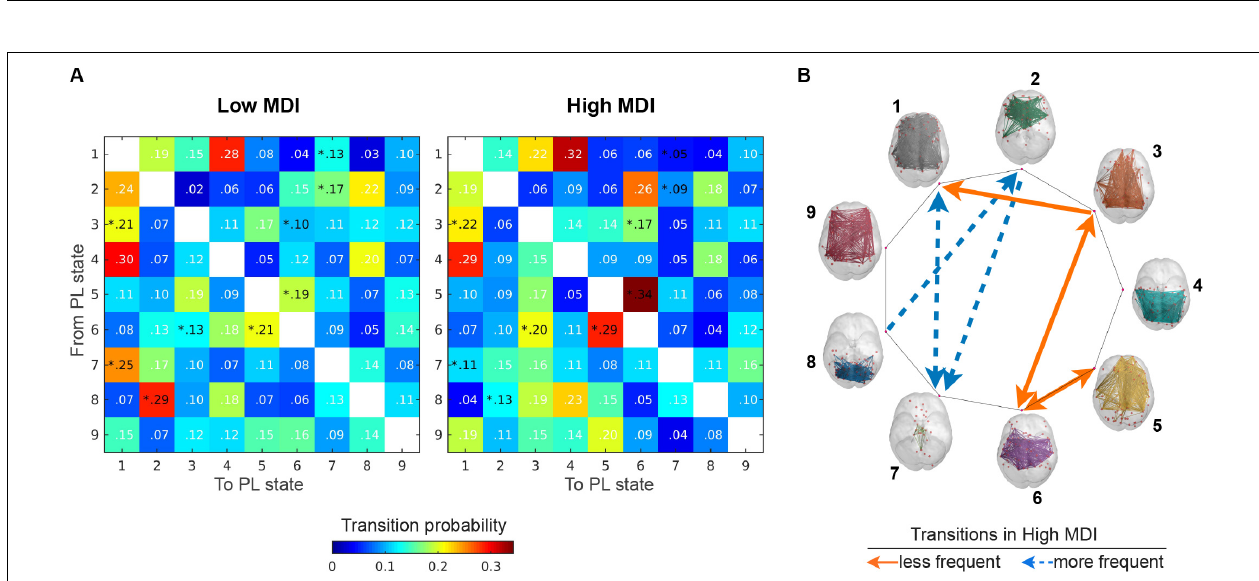
FIGURE 6 | Precuneus FC for the repertoire of nine PL states. (Top) Subnetworks determined by the largest (blue) and smallest (orange) communities in each cluster centroids Vc. Note that Vc captures the main orientation of BOLD phases over all regions and that the sign (positive or negative) of the eigenvector elements are used to separate brain regions in one of the two communities (blue-largest or orange-smallest) according to their BOLD–phase relationship. Below each PL state, the cortical representation of the functional connections involving the precuneus regions for the largest (Middle) and smallest (Bottom) communities. Here, seeds were color-coded according to their assigned functional network, and links were color-coded according to the functional network each precuneus region belongs to. Note that PL states 3 and 8 (i.e., PL states that were expressed significantly different in high vs. low MDI) were zoomed in for visualization purposes (with larger spheres indicating regions of the precuneus). MDI, Major Depression Inventory; PL, phase-locking.